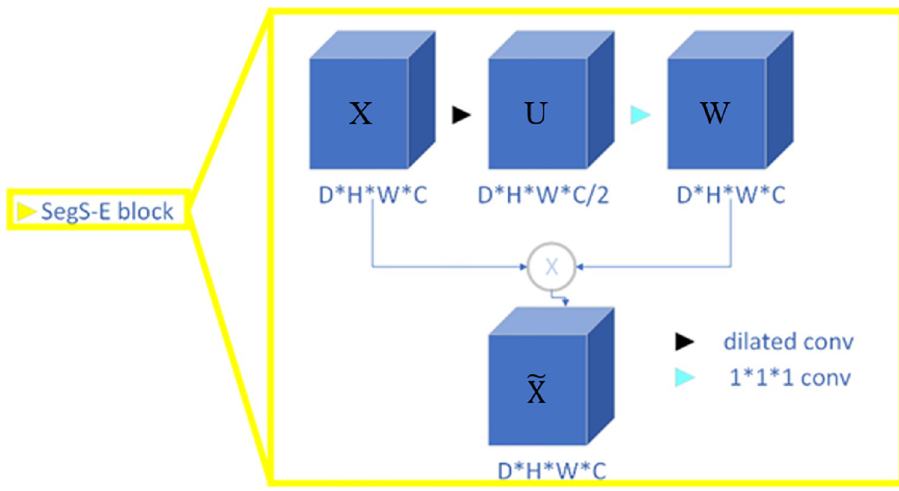
Fig 4. The SegS-E block. “Dilated conv” refers to 3 × 3 × 3 kernel with dilation rate of 2, and “1 × 1 × 1 conv” refers to 1 × 1 × 1 convolution filters.